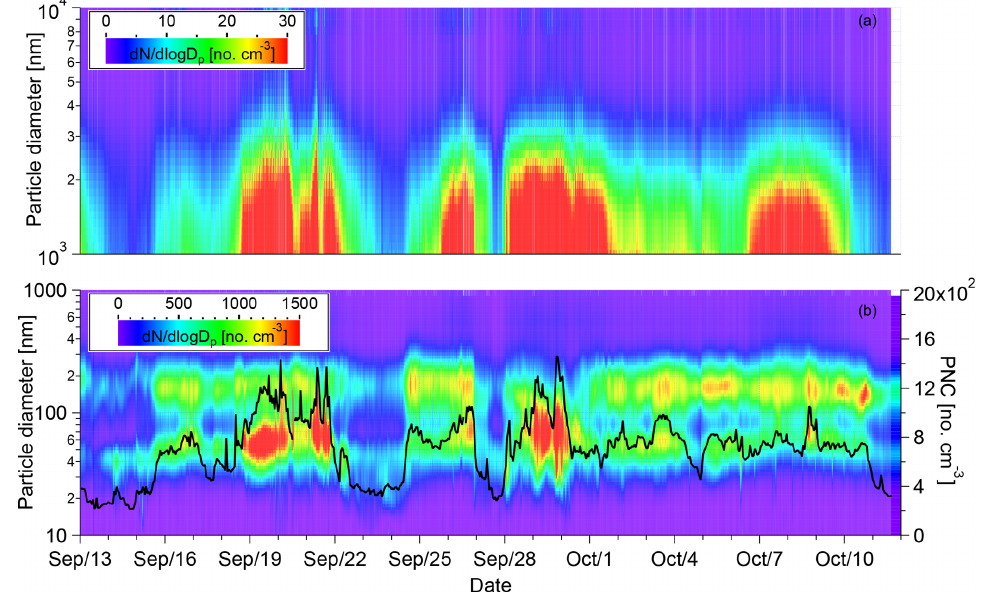
Figure 3. Contour plots for PNSDs of 1000nm to 10µm in panel (a) and 10 to 1000nm in panel (b) . The color scale indicates d N/ dlog D p in cubic centimeters (cm − 3 ). Time series of N total is shown by the black line in panel (b) . with one submicron mode ( N submicron , as shown by purple dots) and one coarse